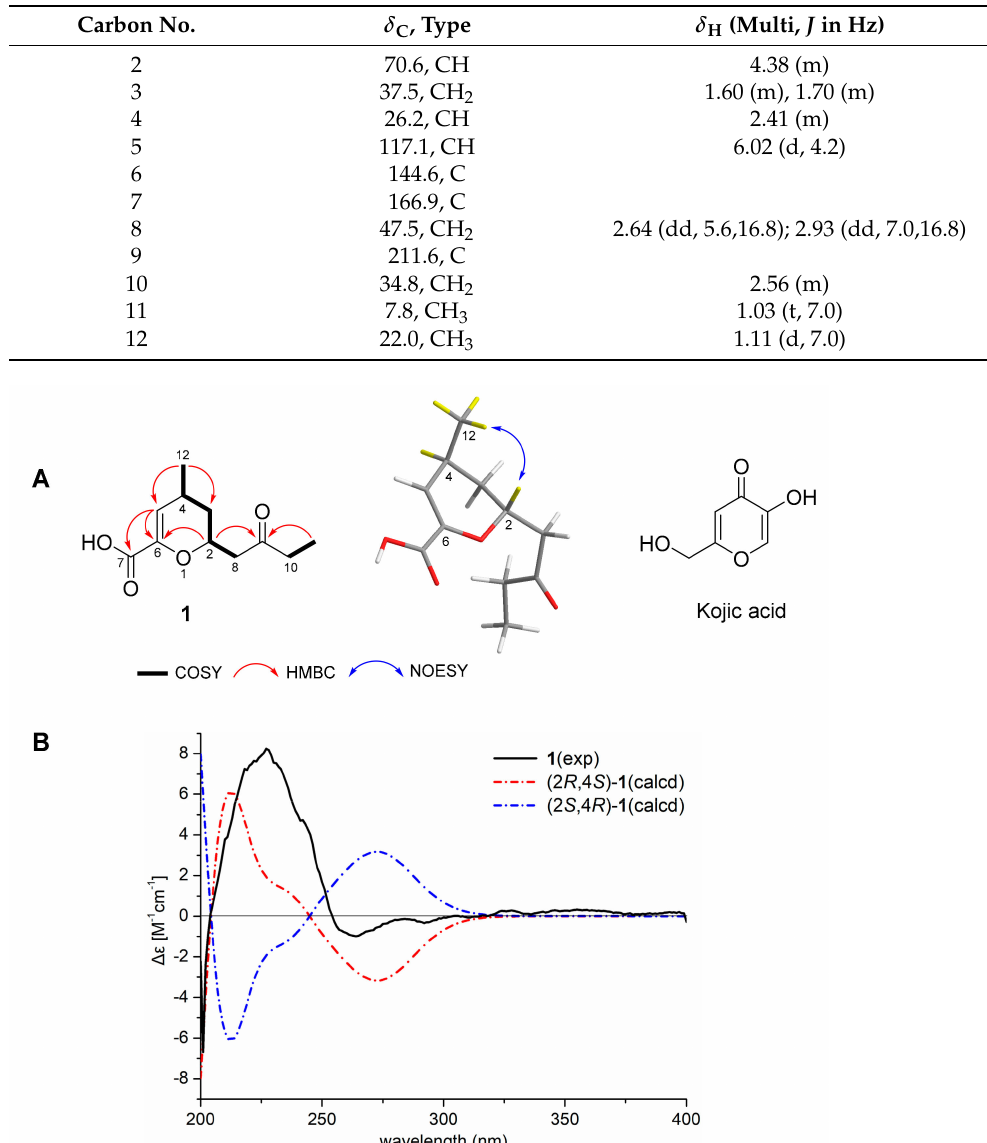
(Figure S6). Different from the n -butyl group at C-2 in 9 , a butan-2-one alkyl side chain was located at C-2 in 1 . This assignmenet was confirmed by the 1 H- 1 H correlation spectroscopy (COSY) correlations between H-10/H-11 and H-8/H-2/H-3/H-4/H-12, and heteronuclear multiple bond correlation (HMBC) correlations between H-2 and C-6/C-9 and between H-11 and C-9 (Figure 2A, Figures S10 and S11). The location of a carboxyl group at C-6 in 1 , different from the methoxycarbonyl group at C-6 in 9 , was supported by the HMBC correlations between H-5 and C-6/C7 (Figure 2A and Figure S10). The trans-location of H-2 and H-4 on the 6-membered 3,4-dihydro-2H-pyran ring in 1 was deduced from the key NOESY correlations between H-12 and H-2 (Figure 2A and Figure S11). Subsequently, the ECD calculations were perfomed on (2 R ,4 S )- 1 and (2 S ,4 R )- 1 , respectively. It was found that the experimental ECD spectrum of 1 was consistent with that calculated for (2 R ,4 S )- 1 (Figure 2B and Figure S13, Tables S1–S3). Therefore, the absolute configurations of 1 were assigned as 2 R ,4 S . Table 1. 1 H (700 MHz) and 13 C NMR data (175 MHz) of cynlindromicin ( 1 , in CD 3 OD). Carbon No. δ C , Type